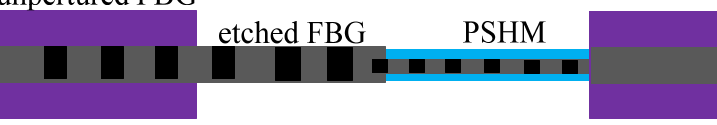
Figure 15. The configuration of the FBG with PSHM [80].